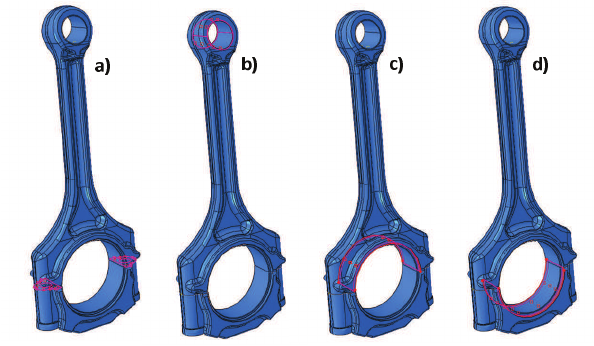
Fig. 2. Contact surfaces between individual elements